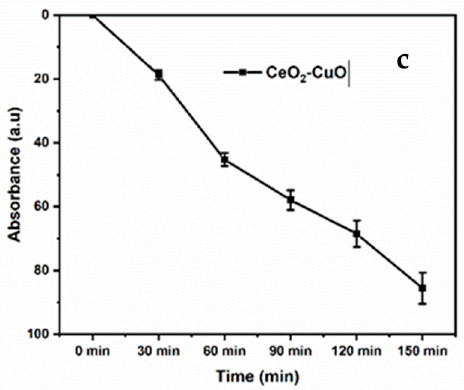
Figure 6. ( a ) Decrease in concentration and % degradation of MB dye with CeO 2 /CuO and ( b ) natural logarithms of absorbance of MB plotted as a function of irradiation time ( c ) standard deviation error bar of CeO 2 /CuO.